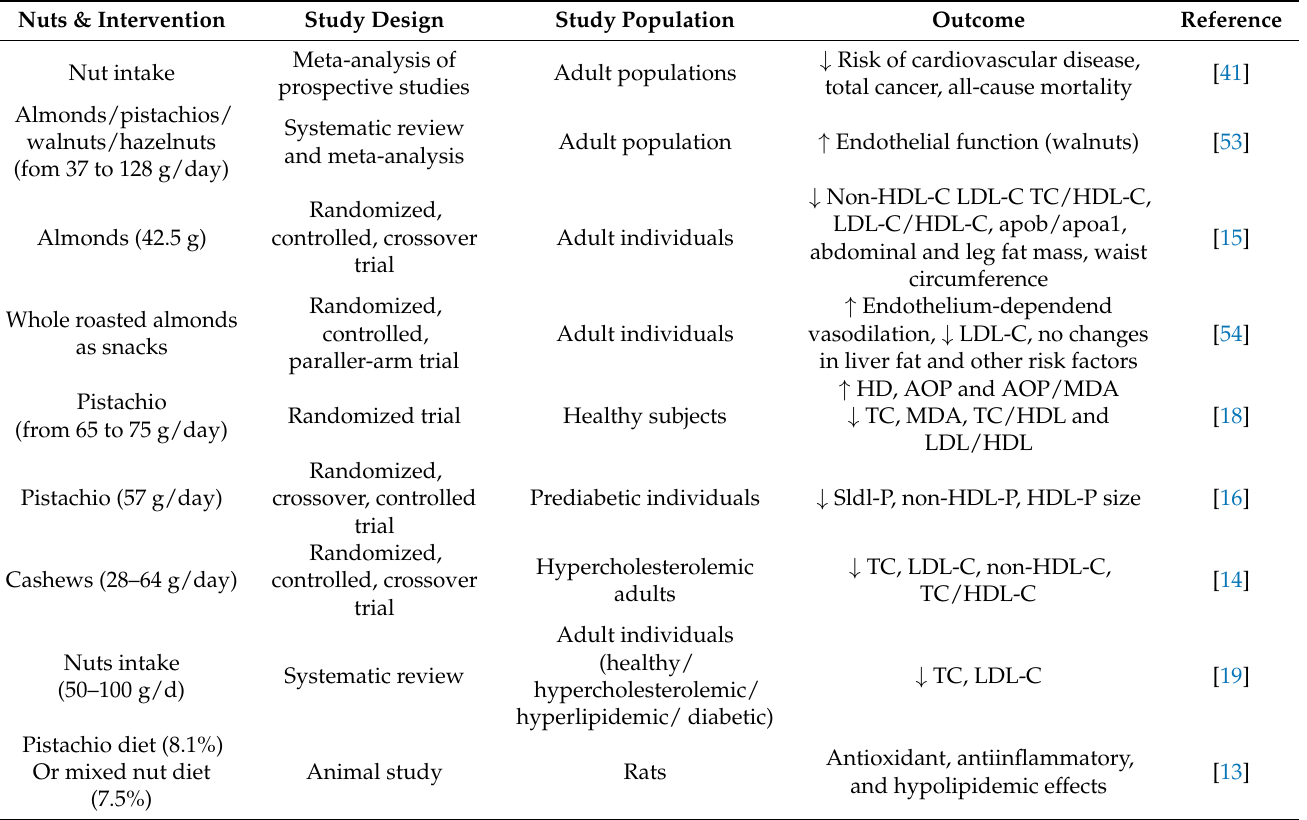
Table 3. Cardiovascular disease prevention and serum lipid effects related to nut